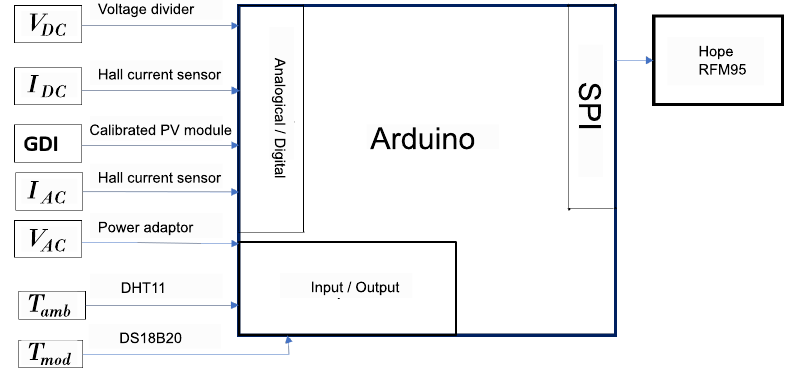
Figure 2. General diagram of sensors and Arduino connections.